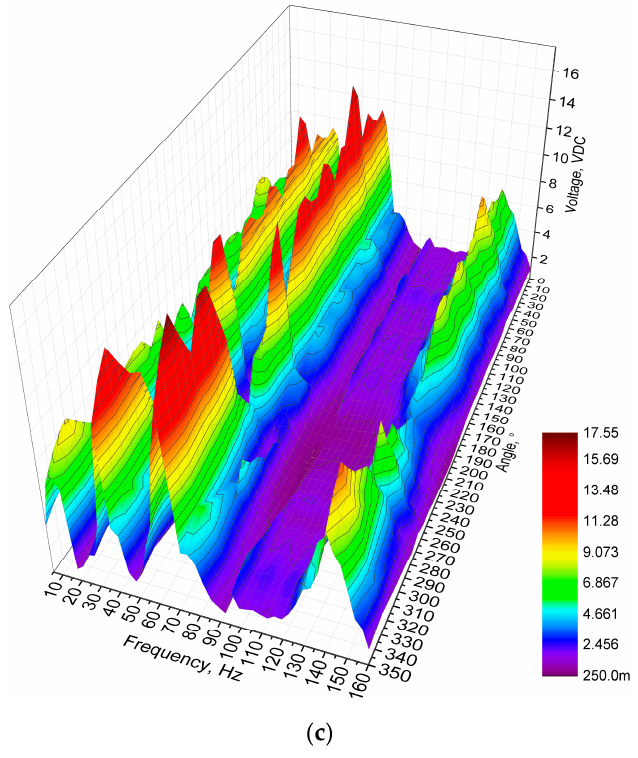
Figure 18. Frequency—voltage—and angle of excitation motion characteristics of the energy harvester with different loads; ( a )—load equal to 1 M Ω ; ( b ) —load equal to 500 k Ω ; ( c )—load equal to 250 k Ω .